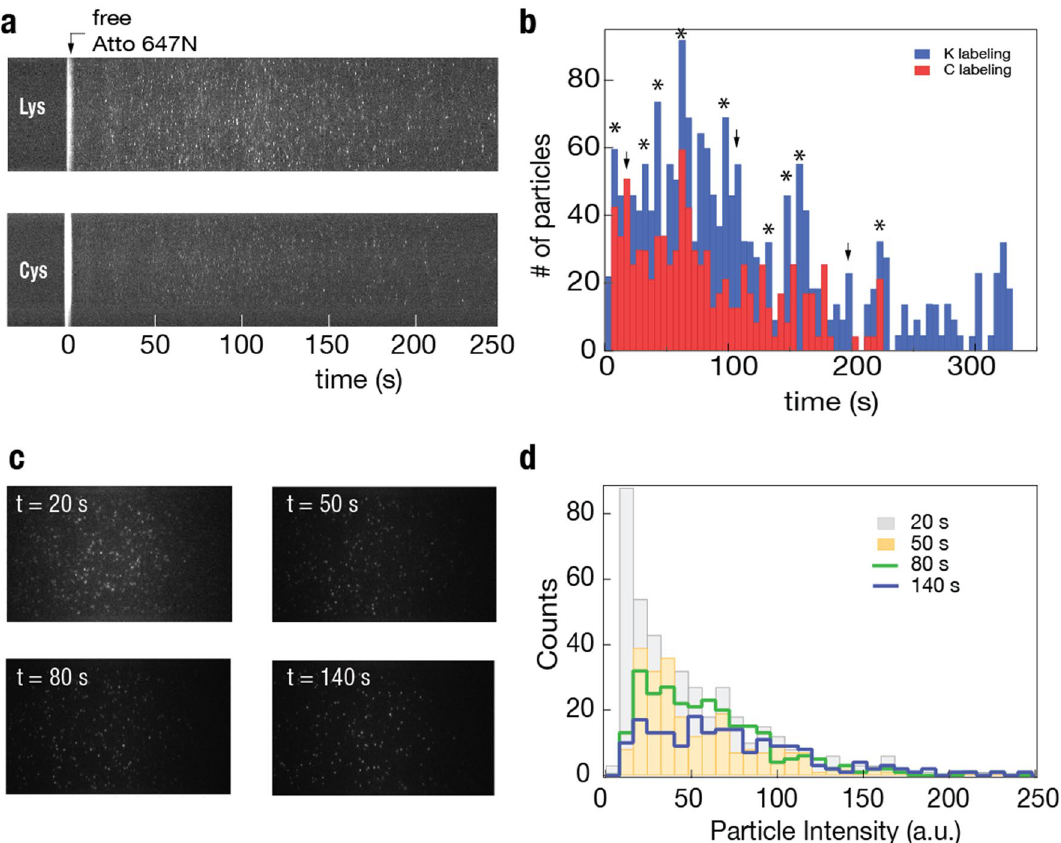
Figure 6. Whole cell extract separations. Proteins extracted from HCT116 colon cancer cells were labeled at the lysine or cysteine residues with Atto647N and separated at 60 V/cm. ( a ) Kymographs for lysine-labeled (top) and cysteine-labeled (bottom) separation experiments where t = 0 s corresponds to the end of the free fluorophore front. ( b ) Single-protein identification histograms as a function of migration time based on the full frame stack analyses. Histograms are binned at 5 s intervals. Asterisks highlight peaks that appear in both the lysine-labeled sample (blue) and the cysteine-labeled sample (red), with a slight delay of the lysine labeling presumably due to their larger molecular weight shift. Arrows refer to peaks that appear differentially in either run. ( c ) Representative video frames correspond to 20, 50, 80, and 140 s for the lysine-labeled experiment. ( d ) Histogram of the proteins’ intensity at different time points, showing a rightwards shift at later timepoints indicating a shift towards heavier but fewer proteins with larger numbers of labeled lysine residues at the longer